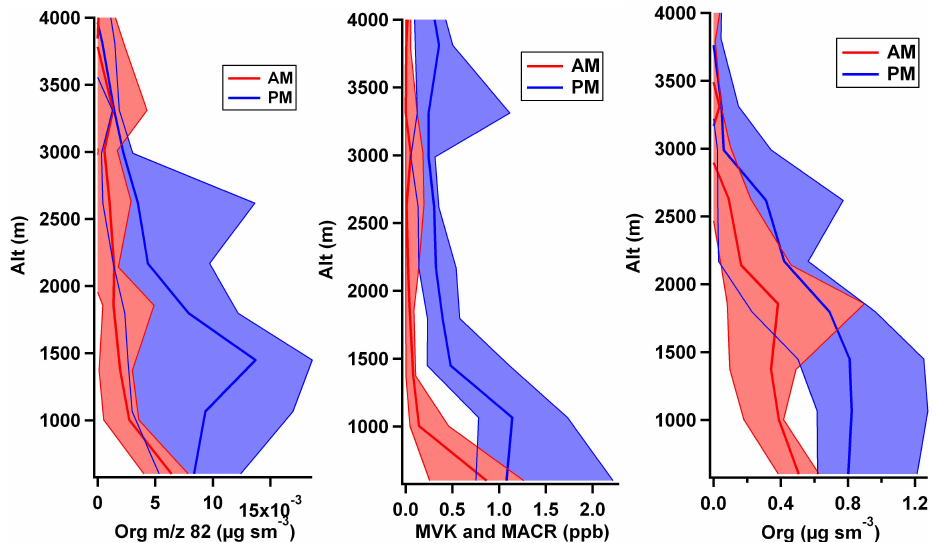
Fig. 6. Average altitude profiles of (a) m/z 82 signal, (b) gas phase MVK+MACR and (c) organic aerosol loading as measured from the FAAM research aircraft. Red lines from data before midday and blue lines from data after midday, local time. Thick lines are median values and shaded areas (outlined with thin lines) denote interquartile